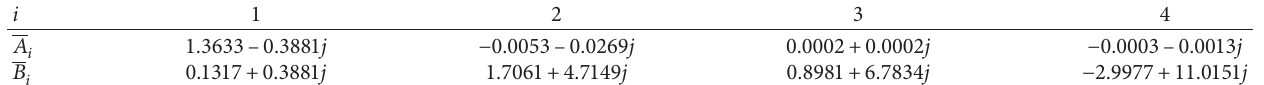
B i and i in equation (17) with DVA.